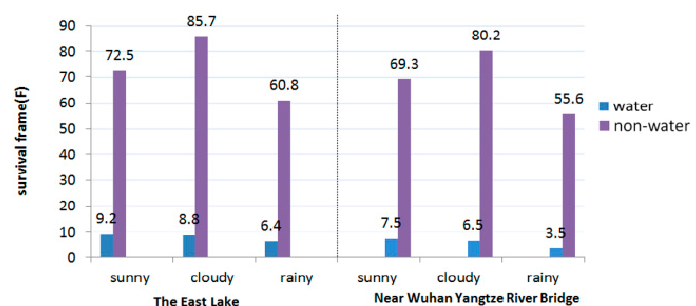
Figure 6. Average survival frames of line segments on the East Lake and near Wuhan Yangtze River Bridge; the blue and purple respectively correspond to the water and non-water area.